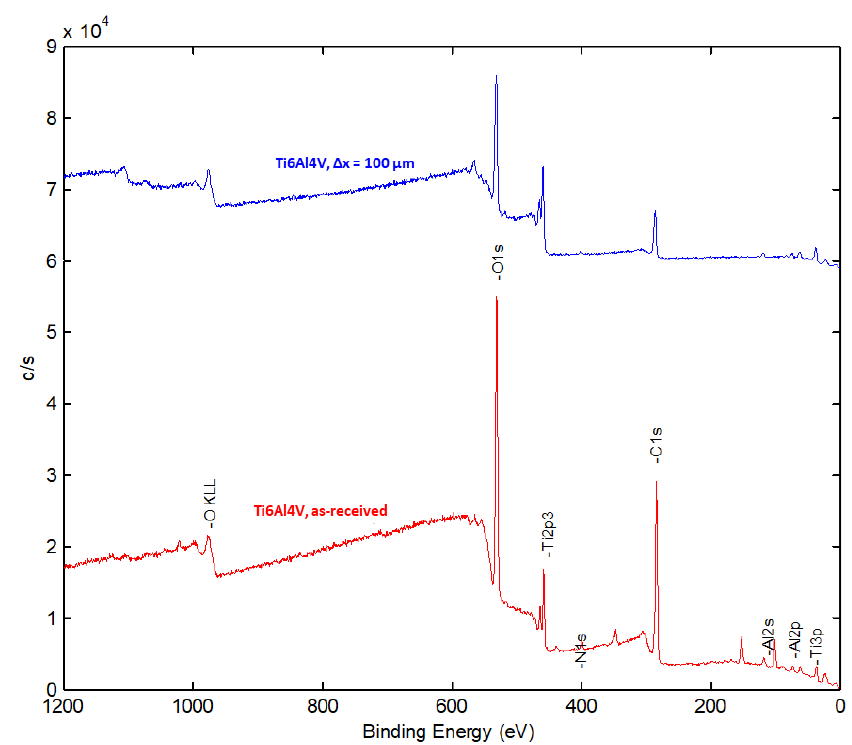
Metals 2020 , 10 , x FOR PEER REVIEW Figure 4. XPS survey spectra of as-received and laser-textured Ti-6Al-4V ( ∆ x = 100 µ m) samples. Figure 4. XPS survey spectra of as-received and laser-textured Ti-6Al- 4V (∆x = 100 μm) samples.